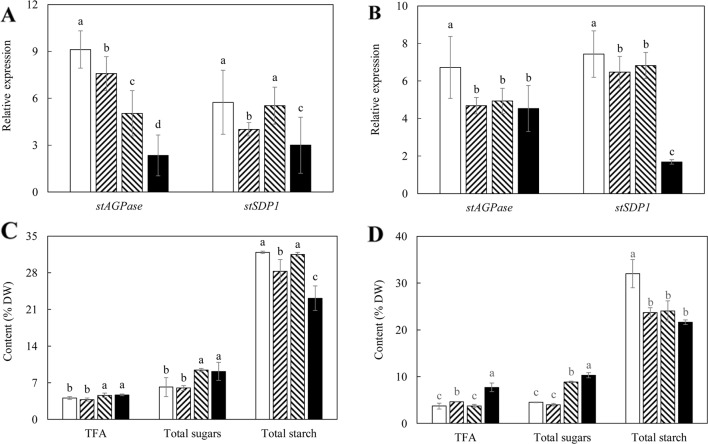
Gene expression analysis and total carbon allocation in the potato tubers of the HO69 (open bars) and three super-transformed lines, 69-L1 (bar with upward trend), 69-L2 (hatched bars) and 69-L3 (black bars) at two developmental stages. (A) Real-time quantitative reverse transcription polymerase chain reaction (qRT-PCR) result at the flowering stage; (B) Real-time qRT-PCR result at the mature stage; (C) Total carbon allocation at the flowering stage; (D) Total carbon allocation at the mature stage. The data represent the mean values ± SD of three biological replicates. Letters (a, b, c) above the bars are based on LSD, bars marked with different letters are statistically significantly different at P < 0.05.